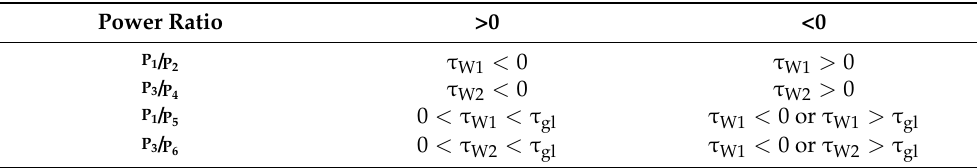
Table 2. Case 1—Ranges of planetary gears speed ratios for each power ratio sign. Power Ratio